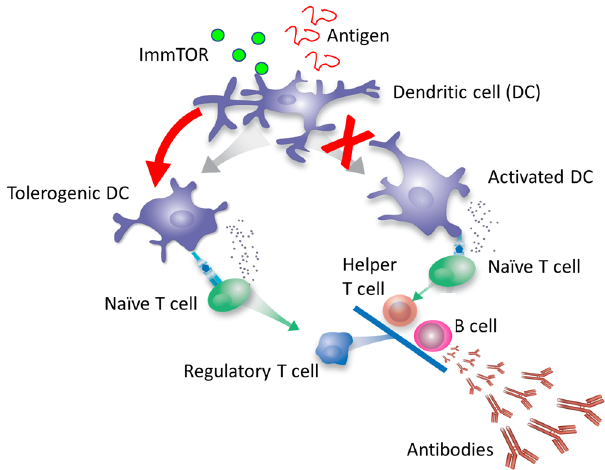
Fig. 1 Schematic of ImmTOR mechanism of action. ImmTOR is selectively taken up by antigen-presenting cells, such as dendritic cells (DC) in the spleen and liver. ImmTOR induces tolerogenic DCs that process and present co-administered antigen in a manner that results in the expansion of antigen-speci fi c regulatory T cells. The Tregs inhibit activation of effector T cells and prevent the formation of anti-drug antibodies. Adapted from Kishimoto 8